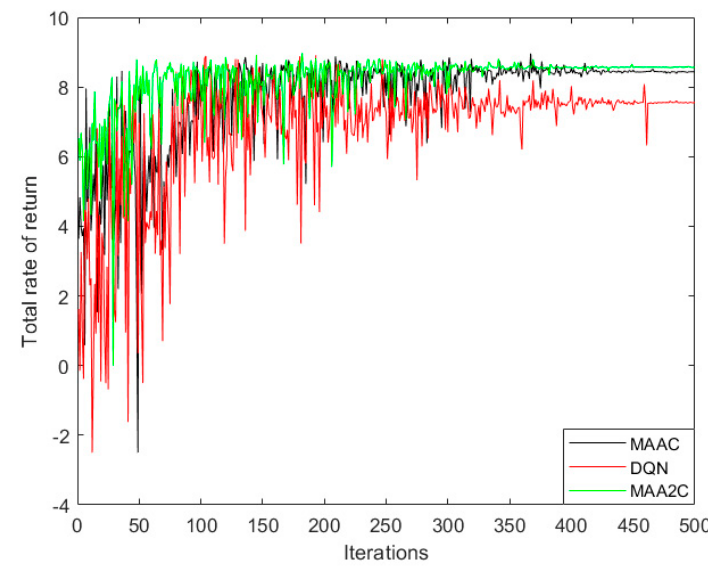
Figure 5. Trend chart of convergence of total return.